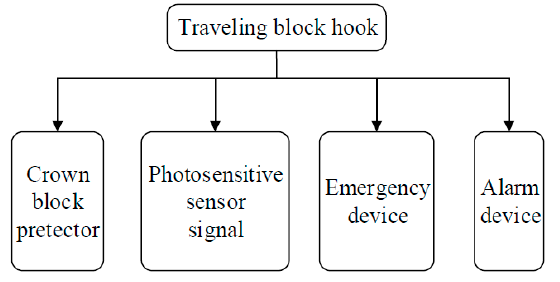
Figure 4. Parameters of traveling block hook.